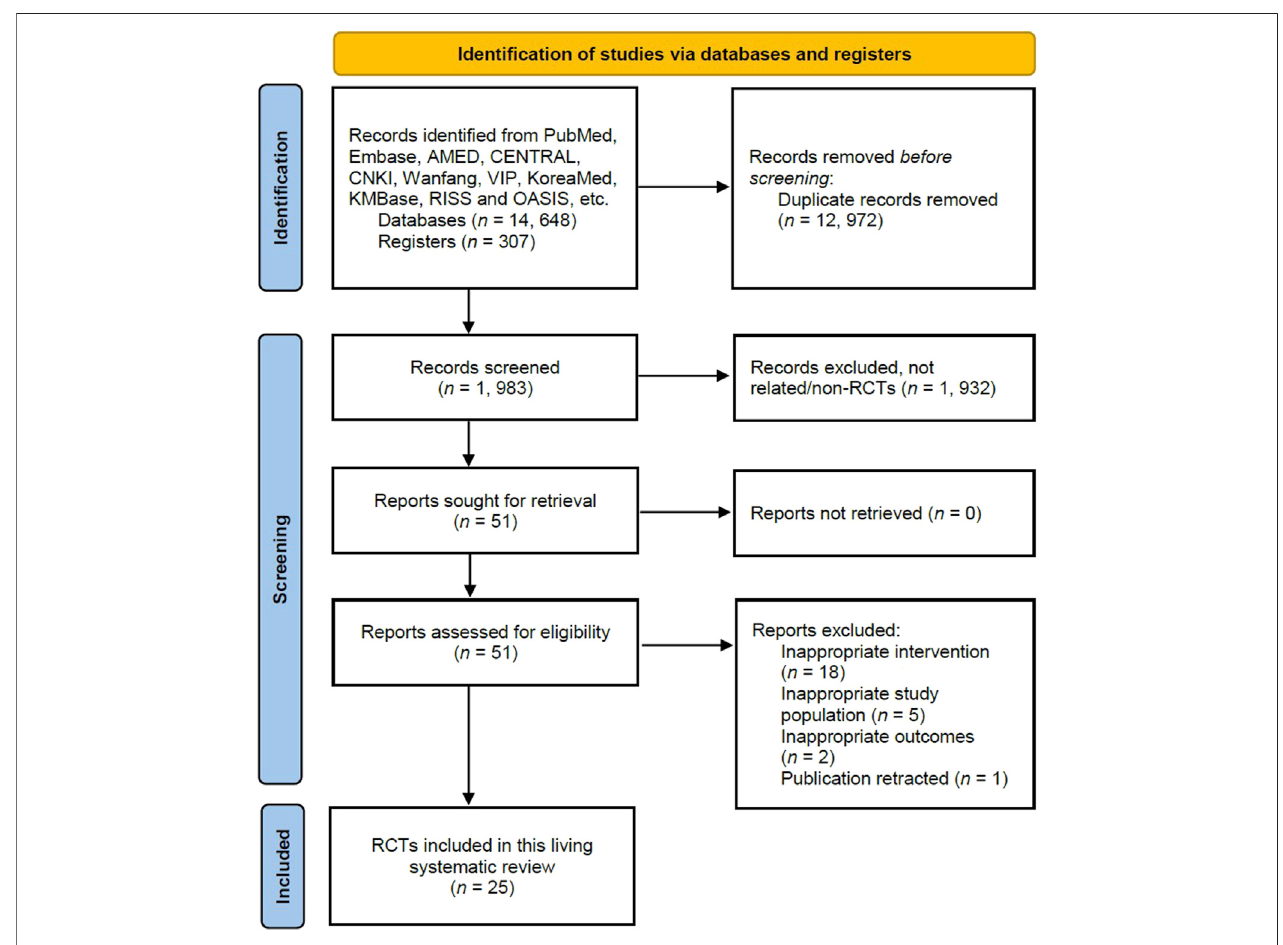
FIGURE 1 | Study selection